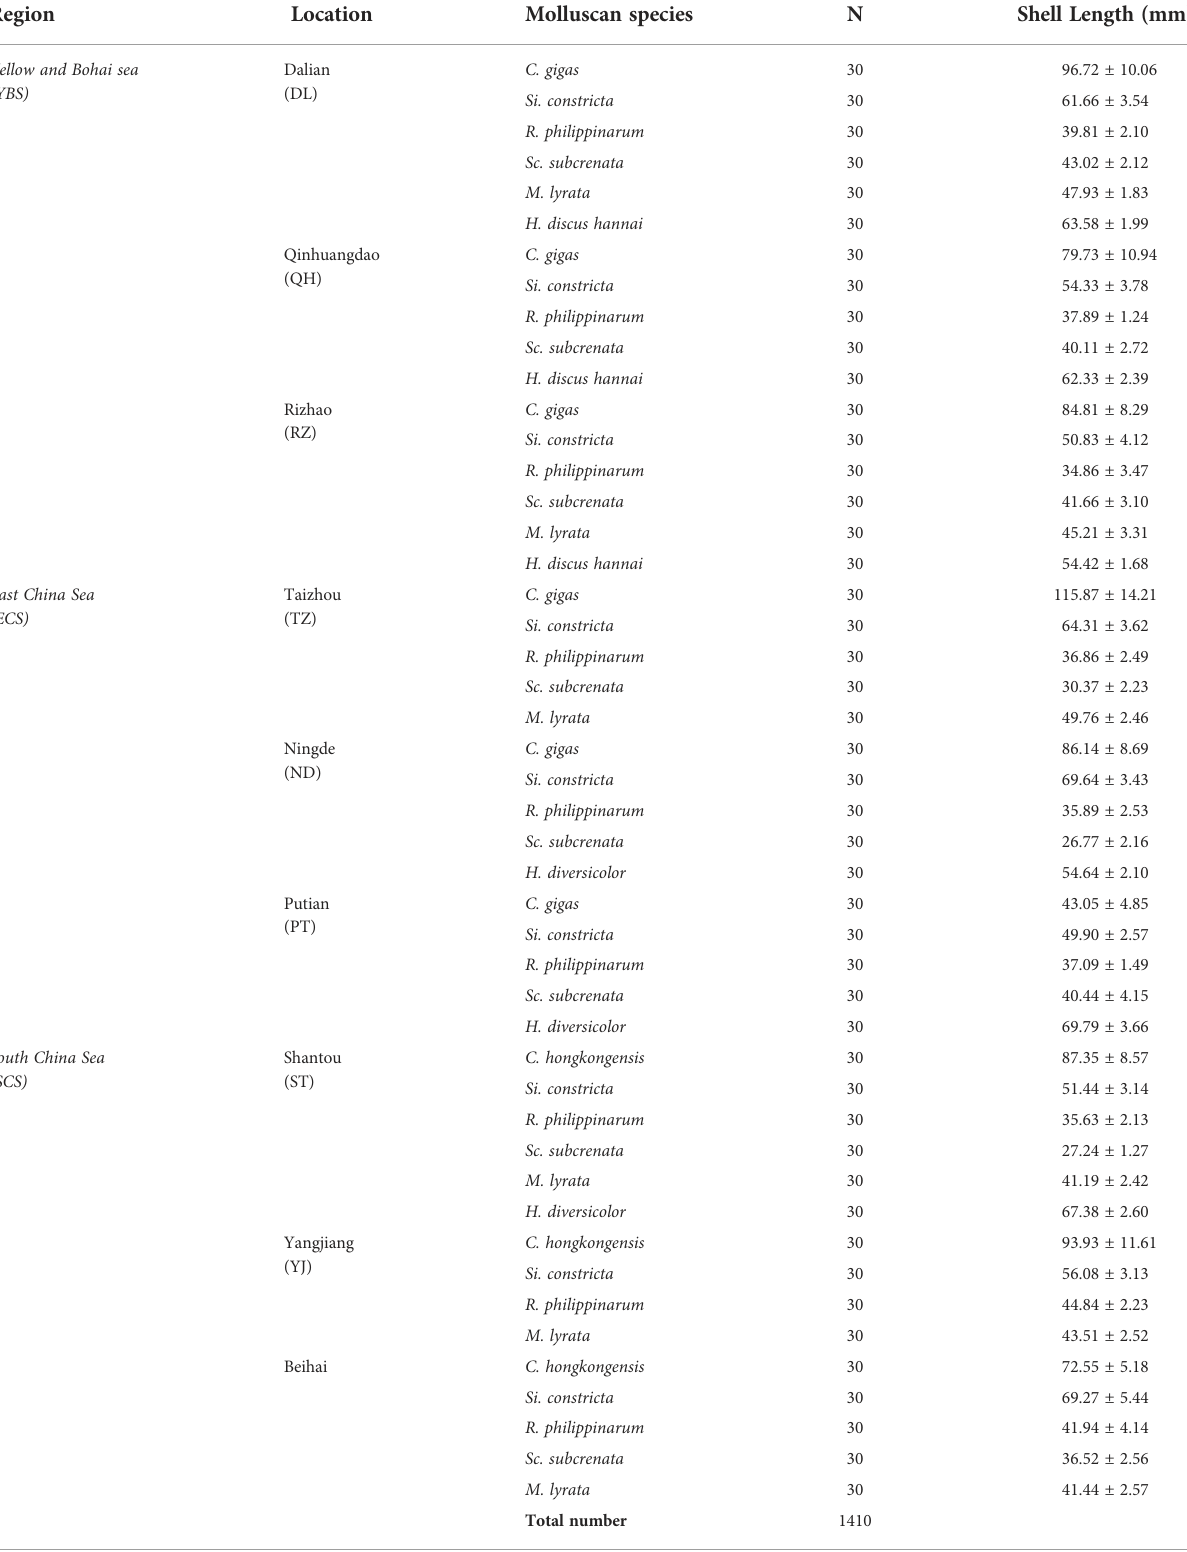
TABLE 1 Sampling information of molluscs along the coastal waters of China.